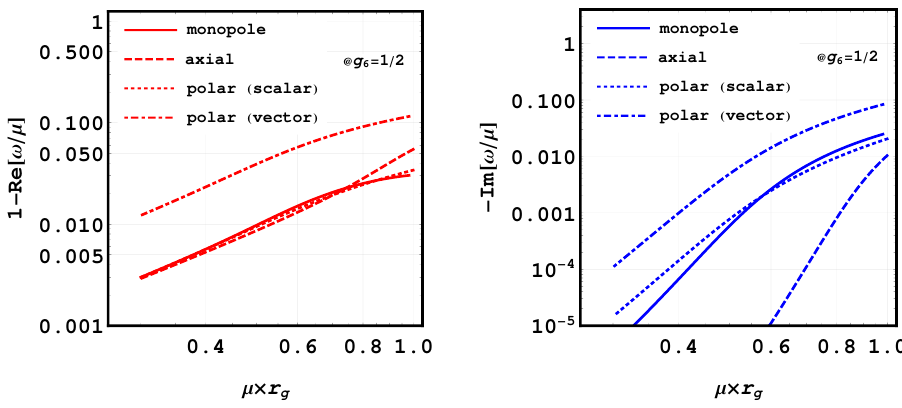
Figure 7 . Power-law behaviour of the fundamental ‘ = 0 , 1 bound states with µ → 0 at an exemplary value of g 6 = 1 / 2